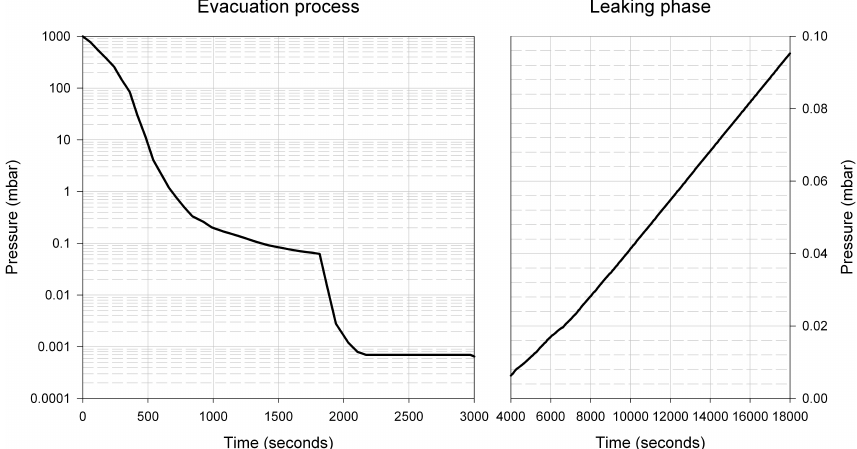
Fig. 2. CESAM chamber absolute pressure plotted against time during a pumping phase (left panel) and the leak rate determination (right panel).